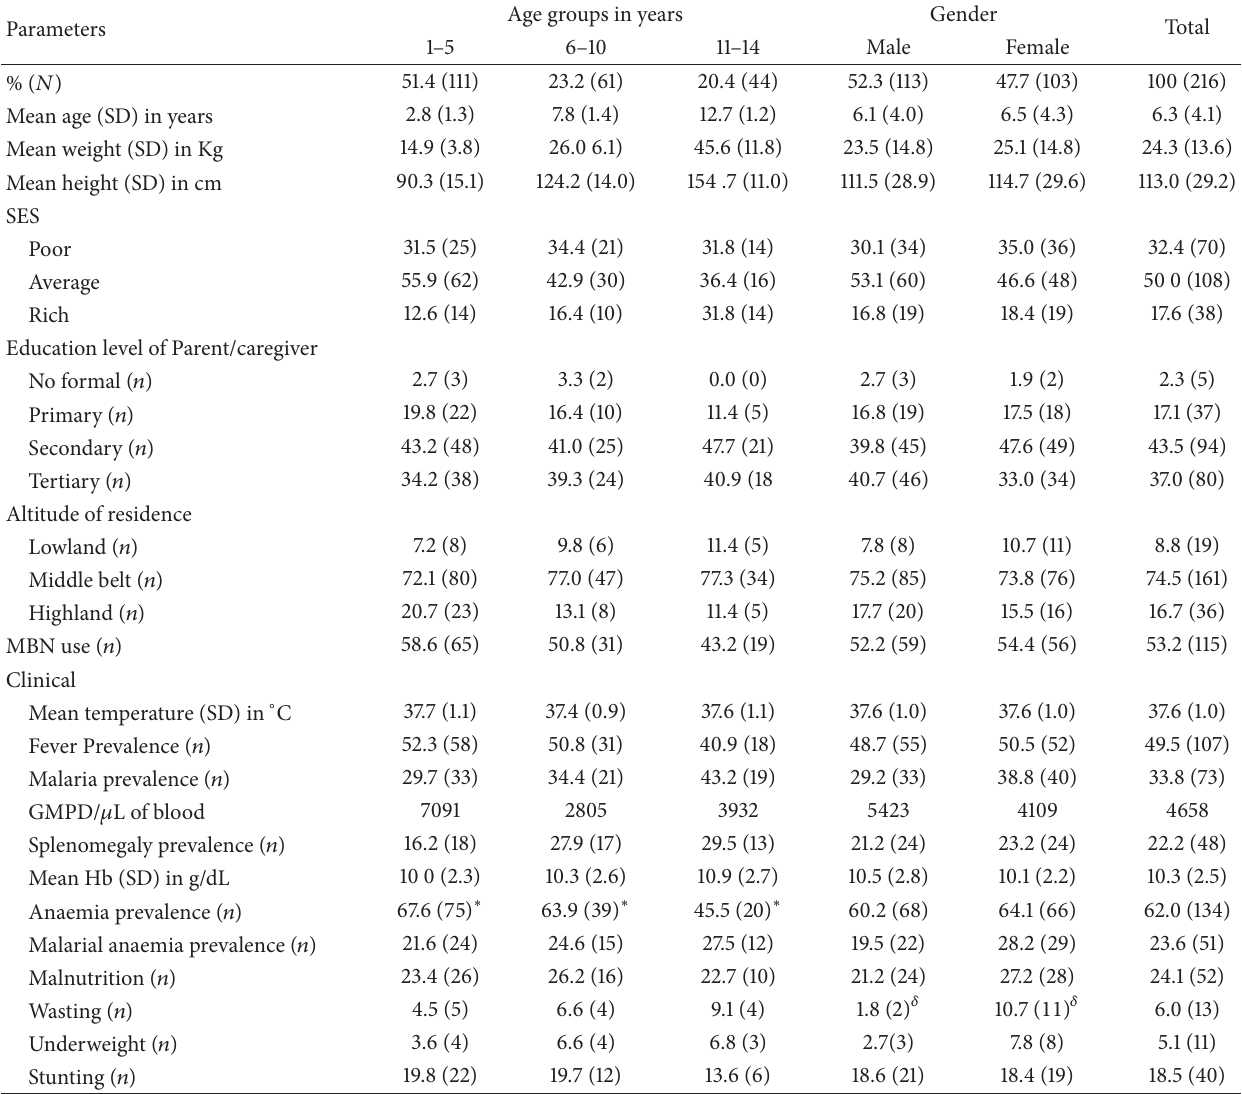
Table 1: Sociodemographic, altitude, and clinical characteristics of the participants by age and